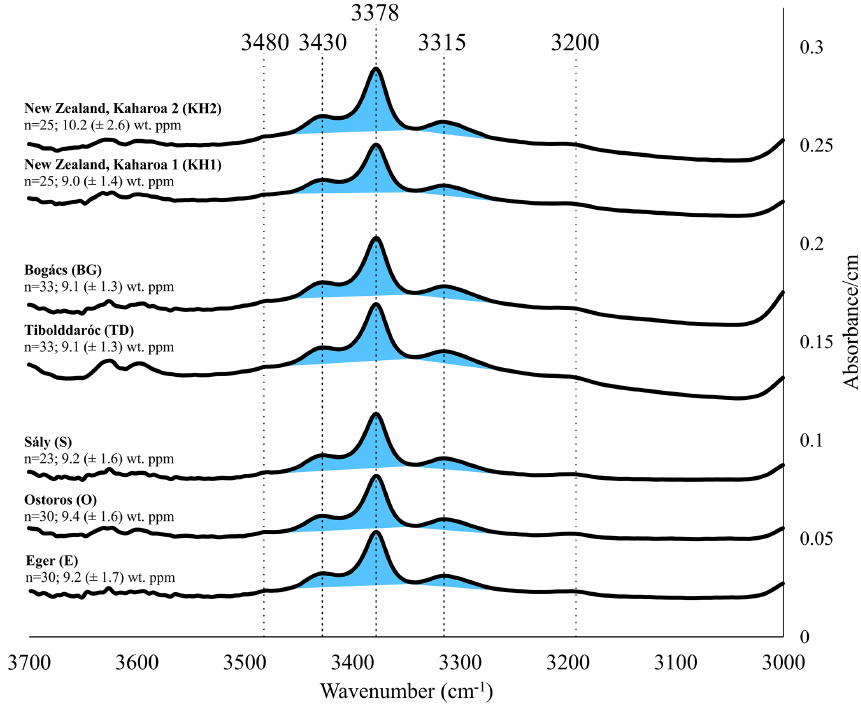
Figure 5. Hydroxyl region of average spectra. The calculated structural hydroxyl content of each sample is indicated with ± 15% analytical uncertainty. n : number of the measured phenocrysts. Blue areas represent the integrated area using OPUS ® B-type integration, on the basis of which the structural OH contents were calculated.